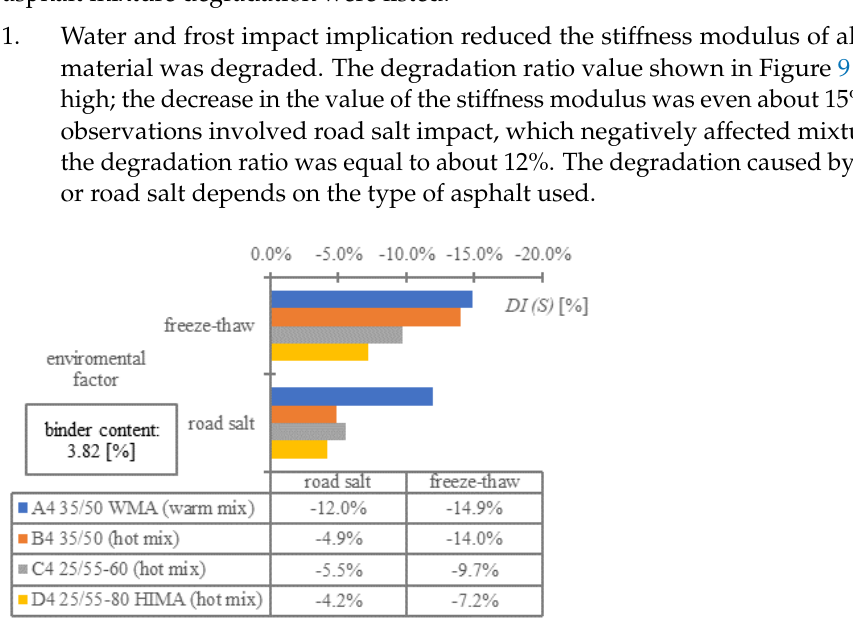
Figure 9. Asphalt mixtures degradation caused by environmental